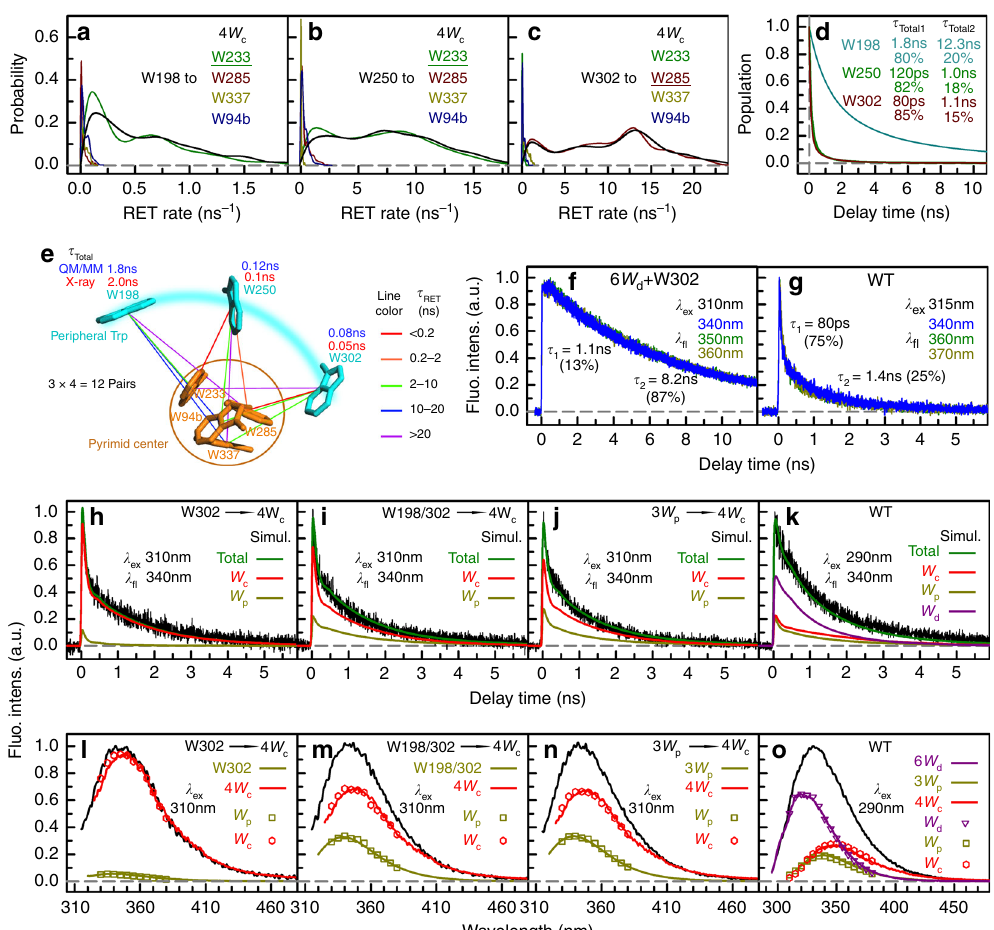
Fig. 3 Excitation-energy transfer from W p to W c . a – c RET rate distributions based on QM/MM calculations for each W p – W c pair. a W198 as the donor. b W250 as the donor. c W302 as the donor. In each fi gure, the distribution of the total RET rate to 4W c is shown in black and the most dominant energy acceptor is underscored. d Simulation of energy-transfer dynamics for 3W p to 4W c based on RET rate distributions. For all 3W p , a fast energy transfer ( τ total1 ) and a slow energy transfer ( τ total2 ) are needed to fi t the transients. e The 12 possible energy-transfer pathways from 3W p to 4W c as calculated with the FRET theory. Each line represents one energy-transfer pathway. Colors of the lines are based on calculated RET time constants. The total RET time constants are shown near each W p . f Fluorescence dynamics of selected 6W d + 1W p at excitation of 310 nm. g Fluorescence dynamics of WT at excitation of 315 nm. h – k Model simulations of typical fl uorescence transients at 340 nm for mutants 6W d + 1W p + 4W c ( h ), 6W d + 2W p + 4W c ( i ), 6W d + 3W p + 4W c ( j ), and WT ( k ). In each fi gure, the black solid line is the experimental data and the green solid line is the total simulation curve, which is the sum of contributed ones from W c (red line), W p (dark yellow line), and W d (purple line). The simulation method is detailed in Methods and Supplementary Methods. l – o Comparison between directly measured and simulation-constructed spectra for 6W d + 1W p + 4W c ( l ), 6W d + 2W p + 4W c ( m ), 6W d + 3W p + 4W c ( n ), and WT ( o ). In each panel, the black line is the total emission. The colored symbols represent the spectra of three W groups decomposed from the total emission based on the time integrals of simulation curves (Supplementary Figs. 9 – 13). Solid lines are directly measured emission spectra of the three W